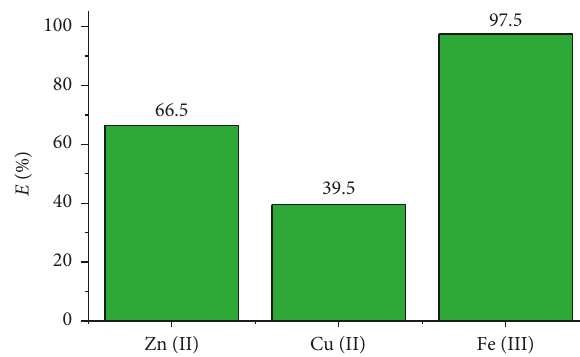
Figure 1: The efficiency of formation complexes.